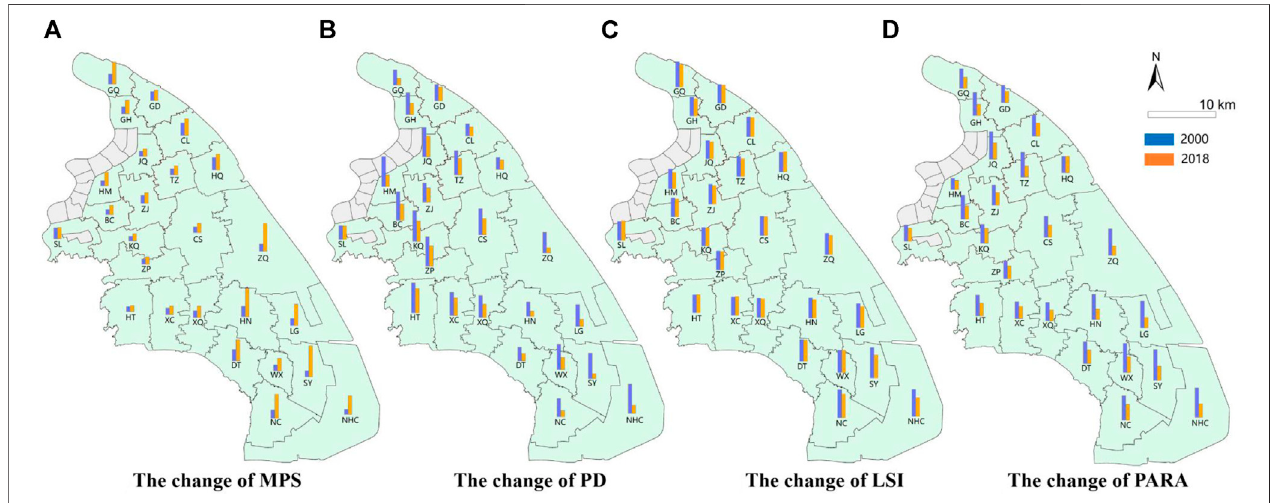
FIGURE 6 | The change of LM at the township level from 2000 to